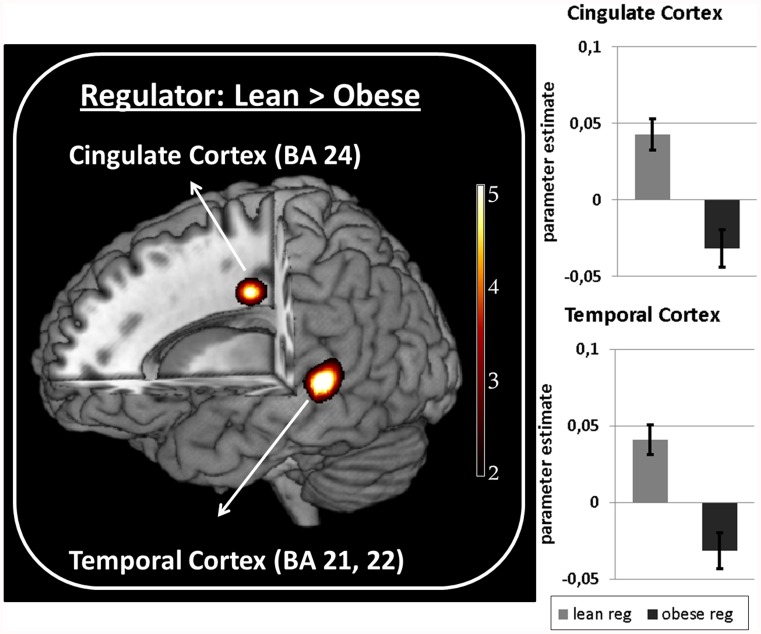
Connectivity differences in lean and obese.Left: Group differences in connectivity strength of the AIC with cingulate (−11 −17 36, T = 4.71) and temporal regions (−59 −35 0, T = 4.79) for lean regulators vs. obese regulators. Color bar shows T values. Right: Bar plots represent parameter estimates ± SEM.